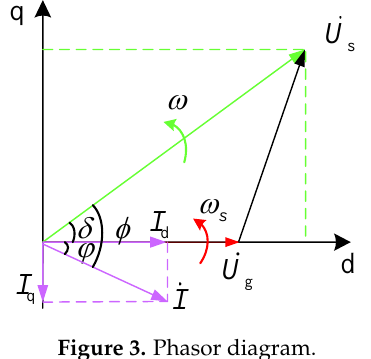
Figure 3. Phasor diagram.